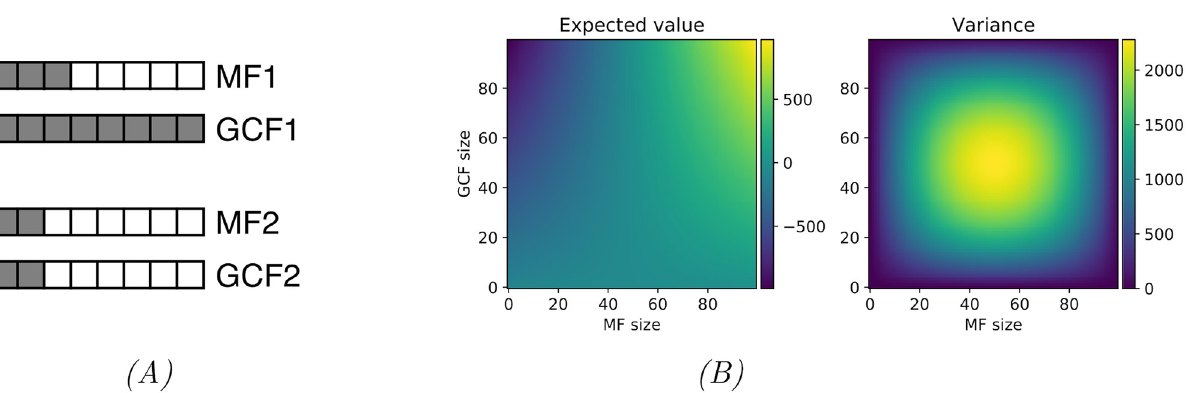
Fig 2. The effect of size on strain correlation scoring. (A) Size discrepancy in the strain correlation score for GCFs of varying sizes. Each box represents a strain, with filled boxes denoting that the strain is a member of the GCF or MF, and blank boxes that it is not. The top GCF-MF pair outscores the bottom pair by 30 to 26, despite the bottom pair having arguably stronger correspondence. (B) Expected value and variance of the strain correlation score for a population of 100 strains, as a function of GCF and MF sizes. Both the expected value and the variance have a considerable range, rendering comparison between links involving different sizes of GCFs and MFs difficult. For instance, a GCF and MF of size 80 could easily get a score of 500 or higher by chance, while for a GCF and MF of size 20, a score this high would be highly significant.